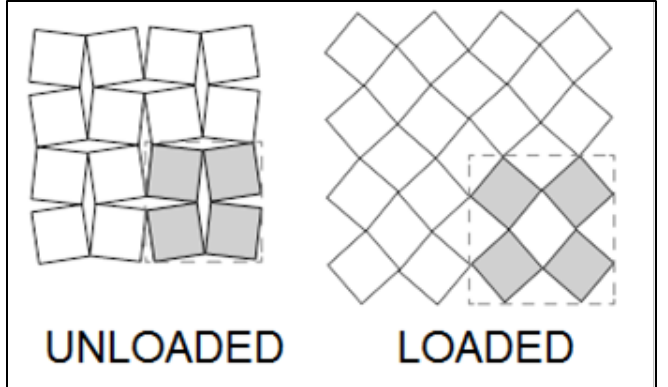
Figure 5. Rotating cell auxetic